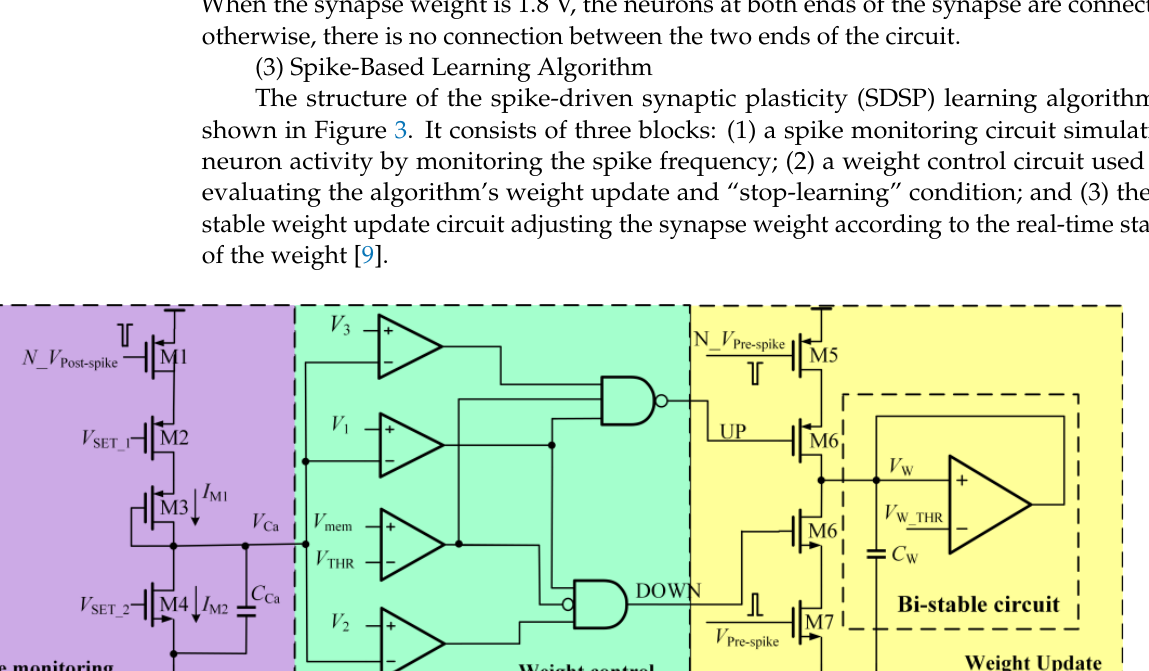
Figure 4. SDSP learning algorithm structure. When the output spike signal V SPIKE_1 from the pre-synaptic neuron is high, the SDSP regulates the synaptic weights by means of Equation (4). Otherwise, the SDSP pulls V W (t) toward the steady-state V MAX (1.8 V) or V MIN (0 V) via Equation (5). When V MO is not within the range shown in Equation (4) (V 1 – V 2 vs. V 1 – V 3 ), the SDSP algorithm does not regulate the synaptic weights, which prevents the neural network from over-regulating the synap- tic weights during the learning process. ( )